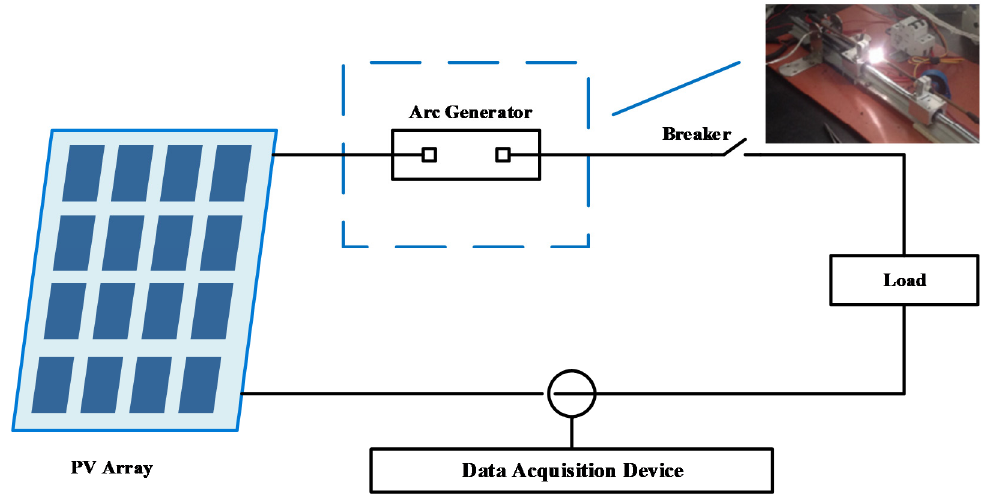
Figure 3. The experimental platform.